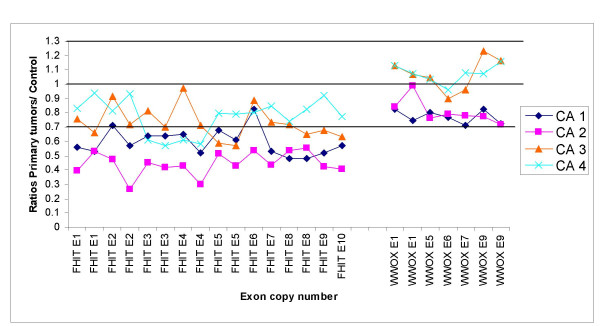
Graphic representation of FHIT and WWOX exon copy number in four primary ESCC tumors. Absolute peak ratios were normalized to control probes not affected in the tumor, (10p, 8p). Exons in their coding order (horizontal axis) have been represented.